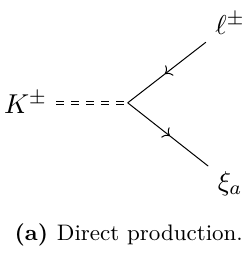
portal vertex that a ‘